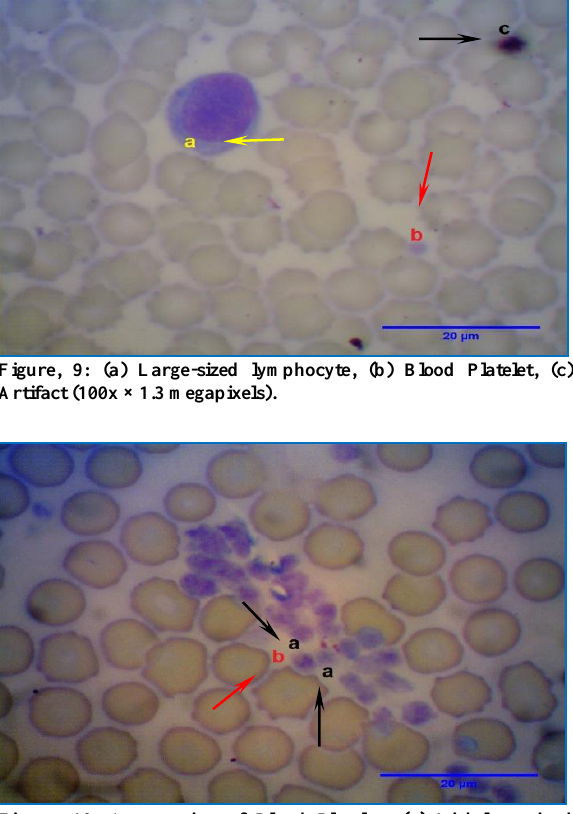
Figure, 10: Aggregation of Blood Platelets (a) Lightly stained peripheral hyalomere, (b) darkly stained central granulomere (100x × 1.3